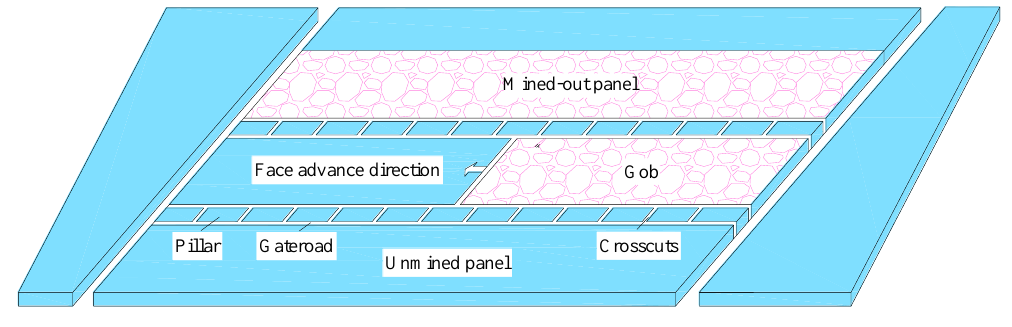
Figure 9. Longwall panel layout.